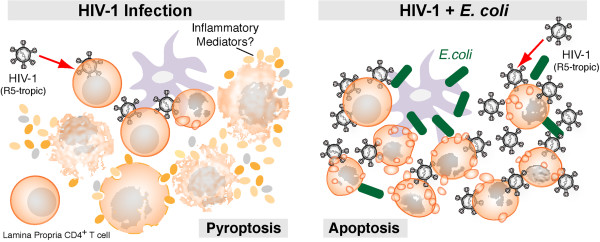
Biphasic model of LP CD4+ T cell death during acute HIV-1 infection. We theorize that in ‘early’ acute infection, prior to extensive microbial translation, pyroptotic death in bystander p24neg cells could account for the majority of LP CD4+ T cell depletion. Inflammatory mediators released during pyroptosis may contribute to epithelial barrier break down. During ‘late’ acute HIV-1 infection, T cells and APCs exposed to commensal bacteria results in enhanced HIV-1 replication, and a shift in the LP CD4+ T cell death pathway to apoptosis. The loss of Th17 cells in particular could further exacerbate epithelial barrier dysfunction and contribute to a cycle of microbial entry, T cell activation, infection and death. Increased apoptotsis from productively infected cells could also contribute to the release of apoptotic microparticles into the periphery, which others have shown could reduce the potency of early adaptive immune responses against HIV-1.